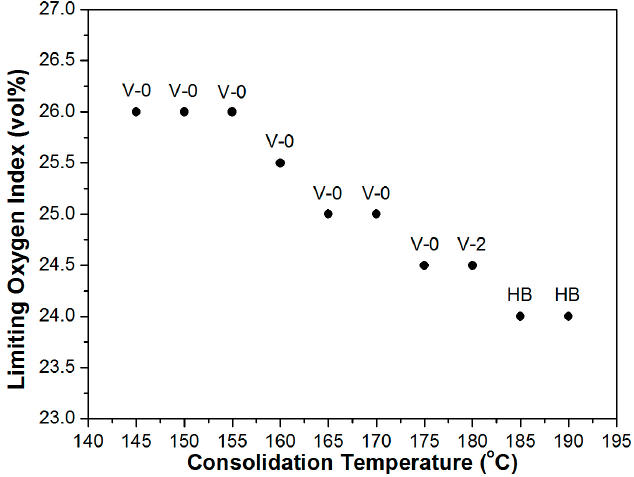
Figure 6. Limiting oxygen index and UL-94 rating of the UD SRCs prepared at different consolidation